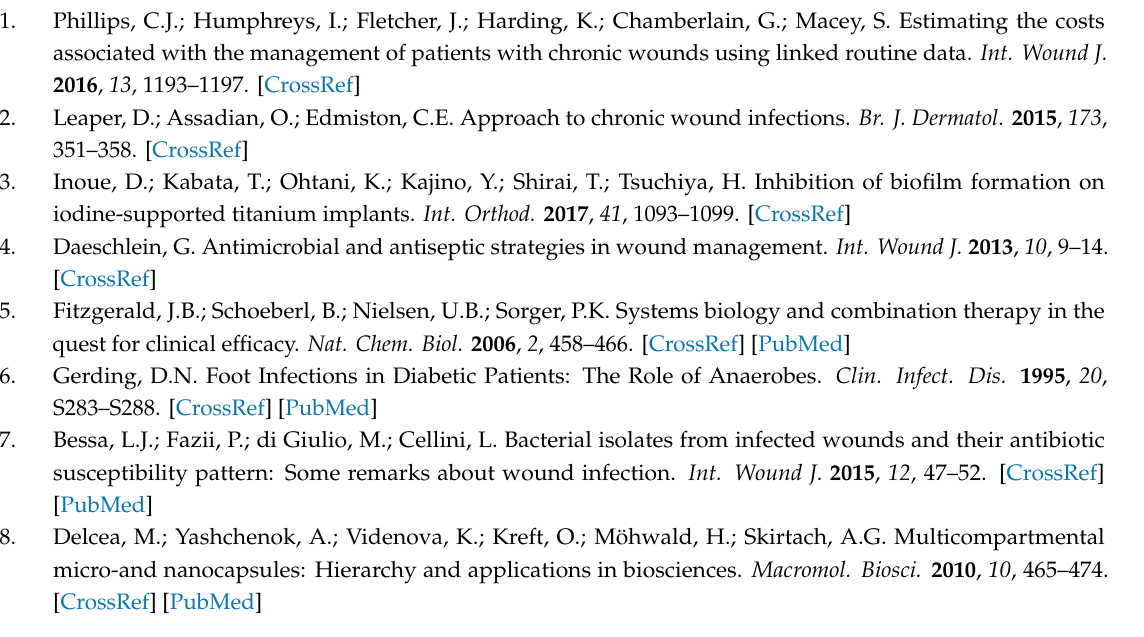
Figure S1: (a) Assembling various components of the portable electrospinning device; (b) the device in operation, producing yellowish metronidazole / iodine loaded fibers; and (c) a schematic representation of the device setup. Figure S2. (a) Fractional release from the delivery systems (blue) and into the outer liquid (orange) as a function of time for scenarios with varying di ff usion coe ffi cients from the delivery system ( D p ) and through the dialysis membrane ( D m ). (b) Cumulative percentage of drug released from the trilayered fibersystems and cream formulations obtained during the study over a five-day period. Figure S3. Photographs of the results showing the growth inhibition of P. aeruginosa following the 24-h incubation of the bacterial cells on LB agar plates with: (a) MTZ cream, (b) MTZ-I cream, and (c) triaxial fibers. Figure S4. A schematic representation of cell sorting using flow cytometry [Image source: Sari Sabban © 2011 / CC BY-SA (https: // creativecommons.org / licenses / by-sa / 3.0)]. Figure S5. Dead / live cell count by flow cytometry of cell suspensions incubated for 24 h for (a) control (without cream or fiber) 4% dead / 96% live, (b) plain fibers without drug 3% dead / 97% live, (c) drug-loaded cream 59% dead / 41% live and (d) drug-loaded fiber 76% dead / 24%